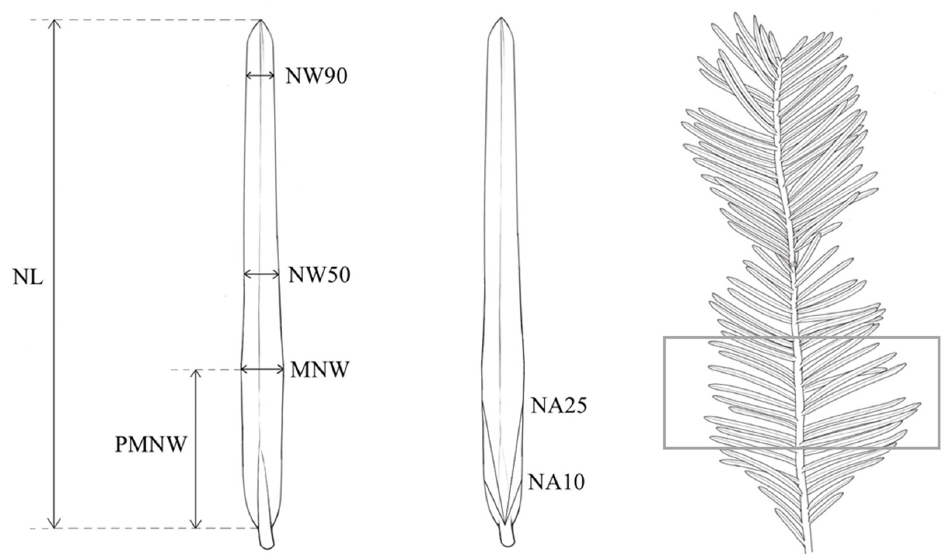
Figure 2. Measured needle morphological traits: needle length measured from the base of the needle up to the tip, along the central vein (NL); maximum needle width (MNW); needle length, measured from base to the widest point of needle (PMNW); needle width at 50% of needle length (NW50); needle width at 90% of needle length (NW90); angle enclosed by the main vein and line between needle base and point at 10% of needle length (NA10); and angle enclosed by the main vein and line between needle base and point at 25% of needle length (NA25). Needles from the middle of the two-year-old shoots were selected for research and are marked with a rectangle.